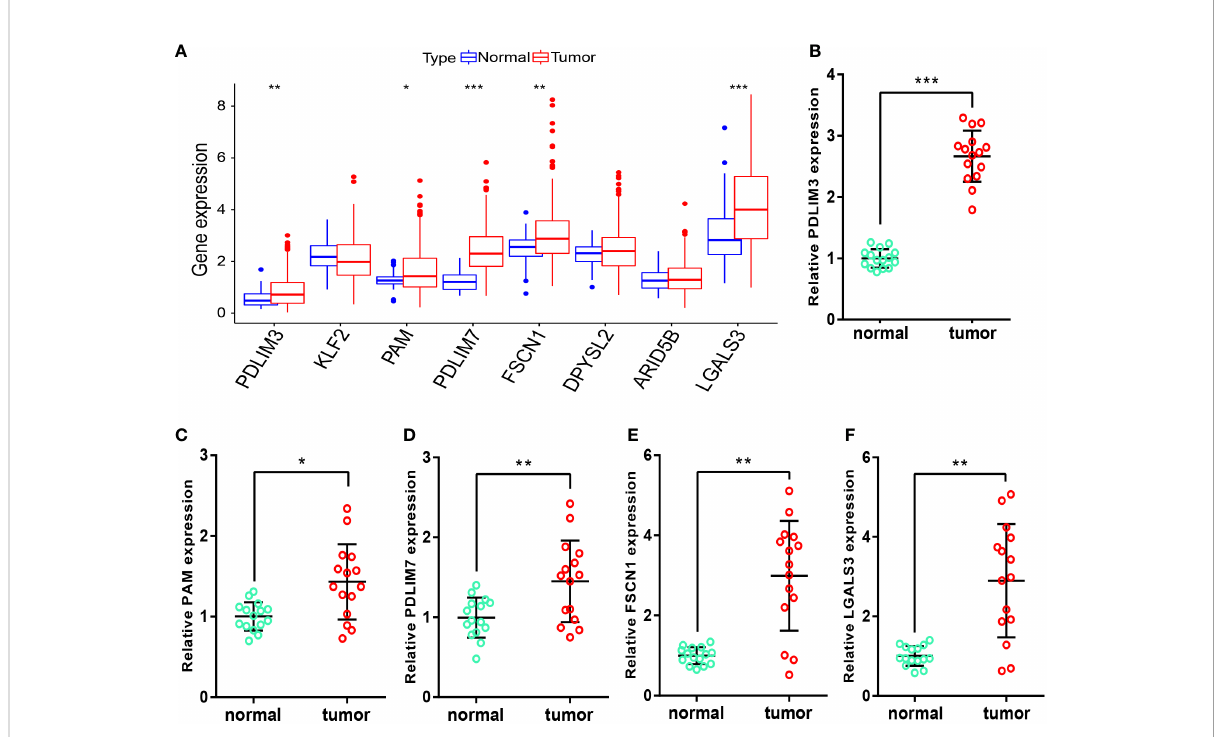
FIGURE 10 Measurement of signature-gene expression in tissues. (A) Expression of signature genes in TCGA-LIHC samples. (B – F) RNA expression of PDLIM3 (B) , PAM (C) , PDLIM7 (D) , FSCN1 (E) , and LGALS3 (F) in tissues. *P<0.05, **P<0.01,